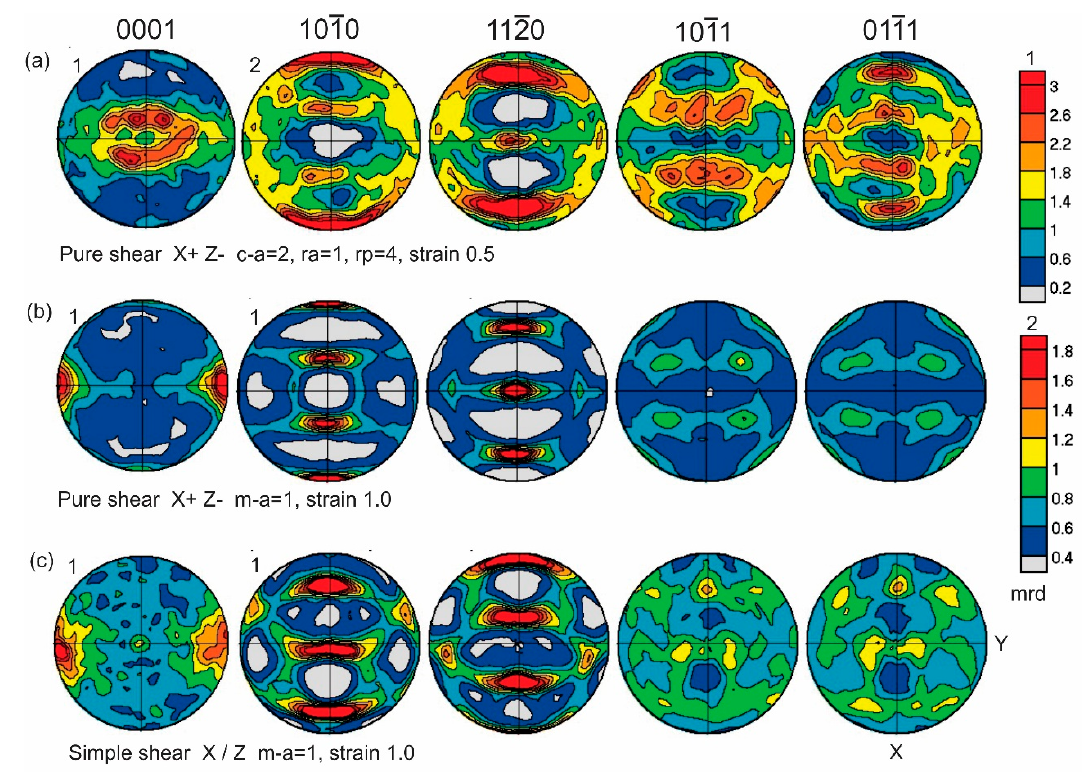
Figure 14. Viscoplastic self-consistent VPSC modeling of quartz textures. ( a ) Pure shear Z compression, X extension, equivalent strain 0.5, basal (0001)<21¯1¯0> (c<a>), and rhombohedral slip {101¯1}<1¯21¯0> ({r}<a>) . ( b ) Pure shear Z compression, X extension, equivalent strain 1.0, prismatic slip {101¯0}<1¯21¯0> ({m}<a>) . ( c ) XZ plane strain, simple shear, X shear direction, equivalent strain 1.0, and prismatic slip {101¯0}<1¯21¯0>. Equal area projection.